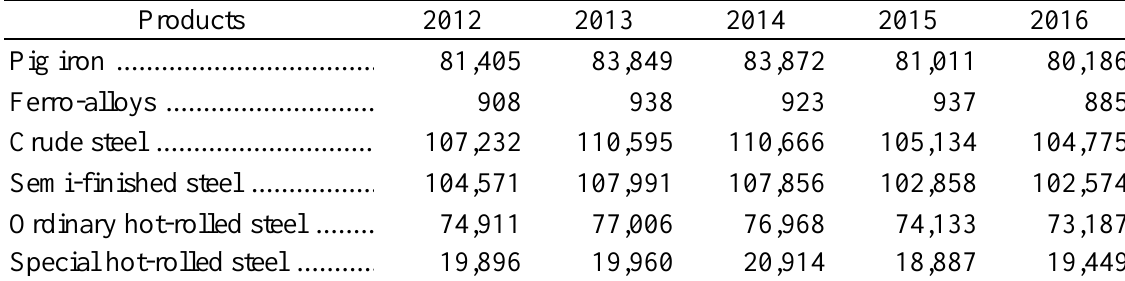
Table 6.3 Steel